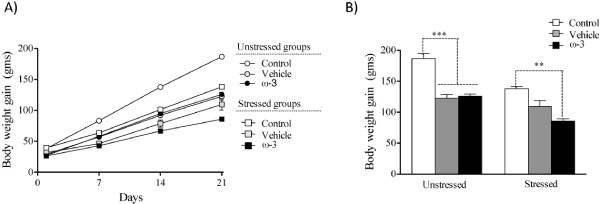
Effect of chronic restraint stress on body weight gain. Rats subjected to restraint stress failed to gain weight (A and B). Differences in body weight gain were observed from day 7 between stressed and unstressed rats from both control and ω-3 groups, and from day 14 for animals from the vehicle groups (A). In contrast, unstressed rats gained weight throughout the study. ω-3: ω-3 supplementation. Data are represented as means ± SEM. An asterisk (*) indicates significant differences.